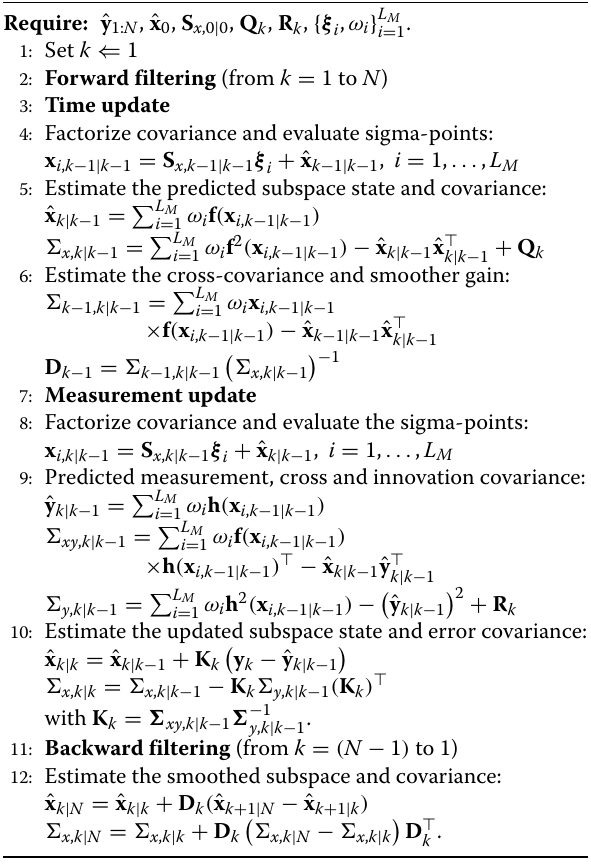
Algorithm 1 Sigma-point Kalman